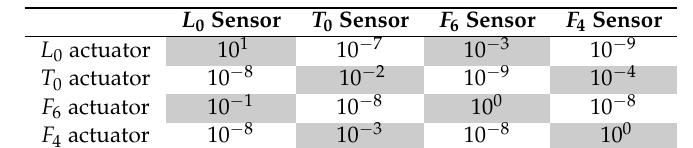
Figure 23. Voltage responses of ( a ) L 0 , and ( b ) F 6 sensors excited by L 0 actuator. Table 4. Magnitudes of voltage responses with damage. Grey color in Non-diagonal elements indicates wave conversions